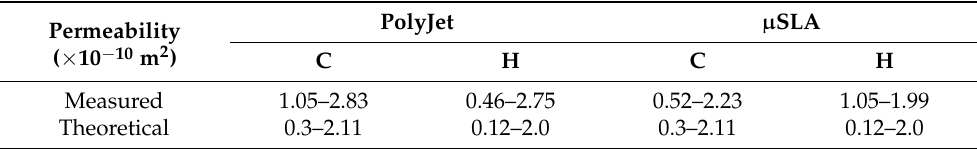
Table 4. Comparison between the measured and calculated values for cubic and hexagonal closed packed 3D-printed scaffold